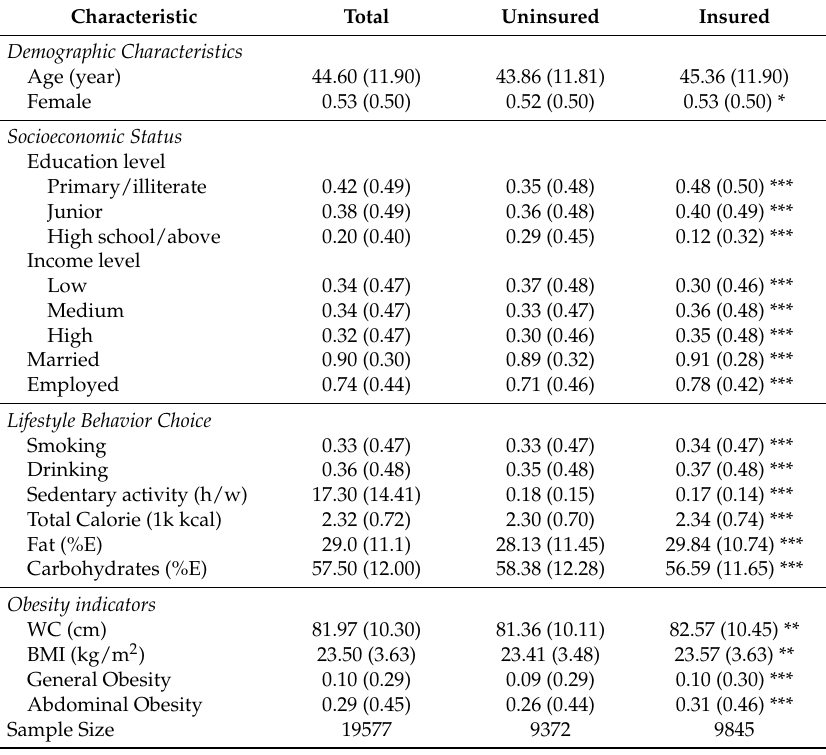
Table A1. Baseline characteristics of 2004–2011 CHNS population by health insurance status.